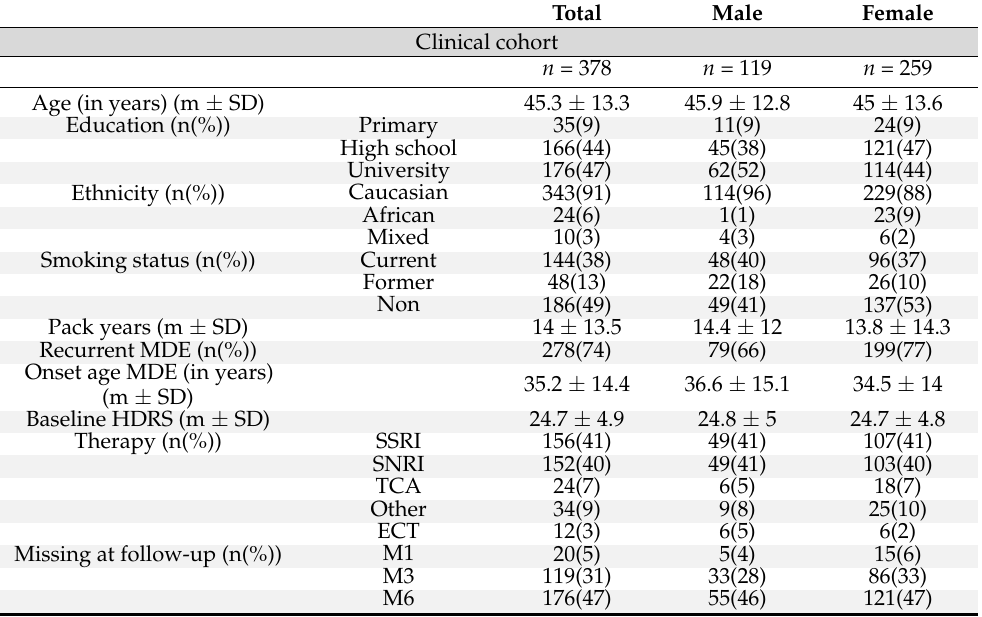
Table 1. Sociodemographic characteristics according to males and